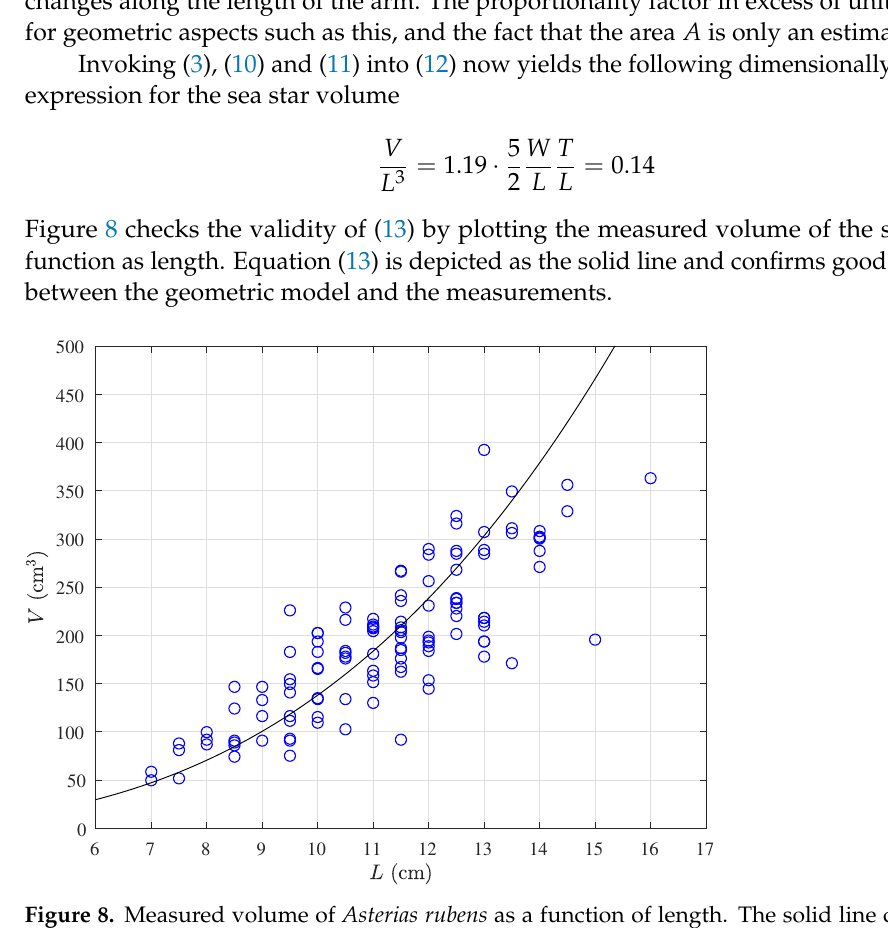
Figure 8. Measured volume of Asterias rubens as a function of length. The solid line corresponds to